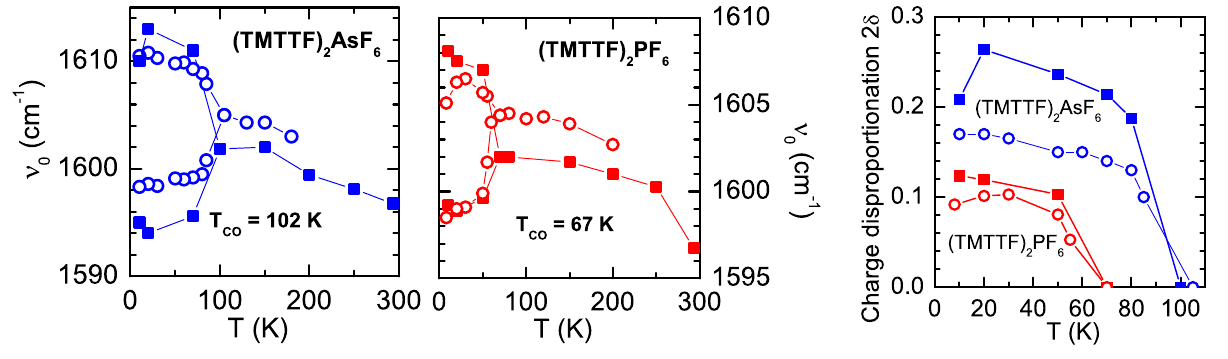
Figure 8. Left two panels: Temperature evolution of the peak frequencies of the ν X obtained from our Raman (open circles) and infrared spectra (filled mode of (TMTTF) 2 squares). The corresponding charge disproportionation 2 δ is plotted in the right panel as a function of